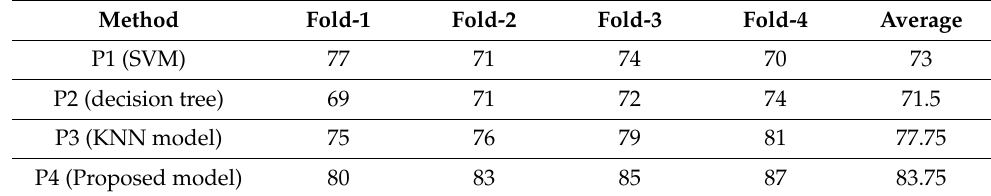
Table 2. Accuracy of the proposed predictive model based on the DDoS